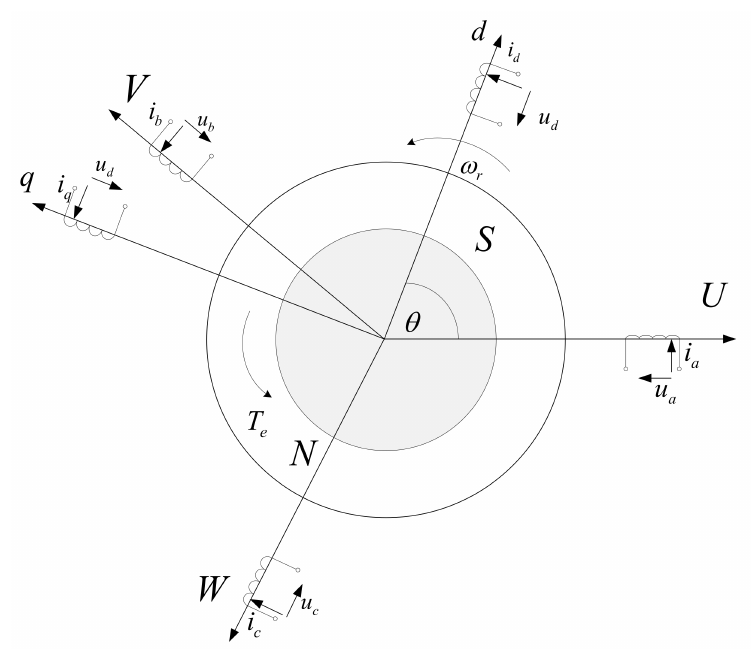
Figure 2. AC servo motor physical model of SPMSM in a plane coordinate